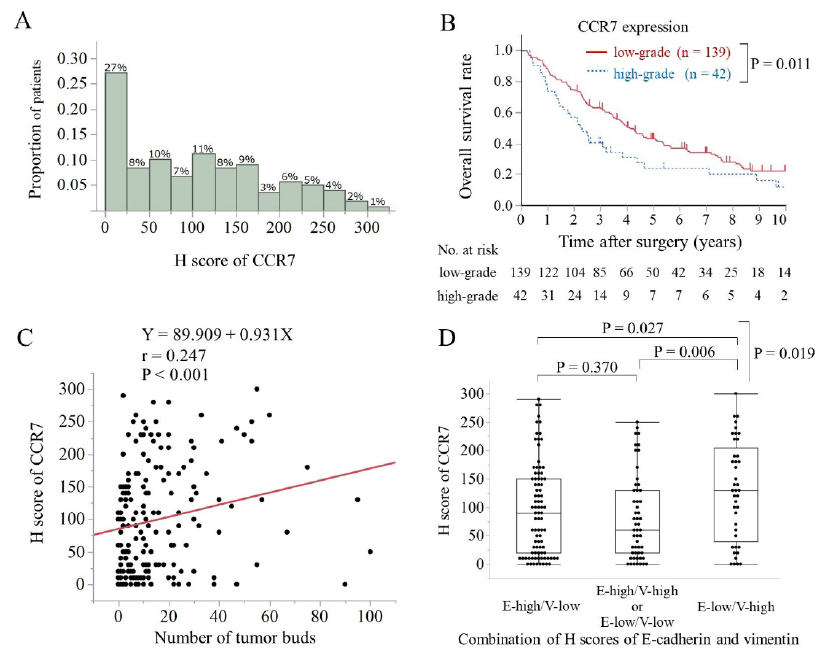
Figure 2. CCR7 expression was associated with poor prognosis and EMT status. ( A ) Histograms displaying patient distribution according to IHC staining scores of CCR7 expression. ( B ) Kaplan– Meier survival curves for the 181 patients with perihilar cholangiocarcinoma based on CCR7 ex- pression grade. According to the log-rank test, patients with high CCR7 expression had a signifi- cantly worse long-term overall survival rate than those with low CCR7 expression ( p = 0.011). ( C ) The correlation between IHC staining scores for CCR7 expression and the number of tumor buds was assessed using Spearman’s rank method. High CCR7 expression grade was associated with the number of tumor buds ( p < 0.001). ( D ) The relationship between CCR7 expression and the combina- tion of the H scores of E-cadherin (E) and vimentin (V) was assessed using an analysis of variance with post-hoc pairwise t -test. High-grade CCR7 expression correlated significantly with EMT status ( p = 0.019). 3.2. Clinicopathological Features and Overall Survival were Associated with CCR7 Expression High-grade CCR7 expression was associated with poor histological differentiation ( p = 0.003; chi-squared test) and microscopic venous invasion ( p = 0.036; chi-squared test) (Table 1). The median (range) follow-up time after surgery was 40 (3–231) months. Table 2 summarizes the results of the univariate and multivariate analyses of the effects of clini- copathological factors on postoperative OS in 181 patients with PHCC. Patients with high- grade CCR7 expression exhibited a significantly worse OS than those with low CCR7 ex- pression according to the log-rank test ( p = 0.011; Figure 2B). Moreover, multivariate anal- ysis identified CCR7 protein expression level (HR, 1.67, 95% CI, 1.10–2.48, p = 0.017) and pT and pN classification as the independent prognostic factors for OS in patients with PHCC.